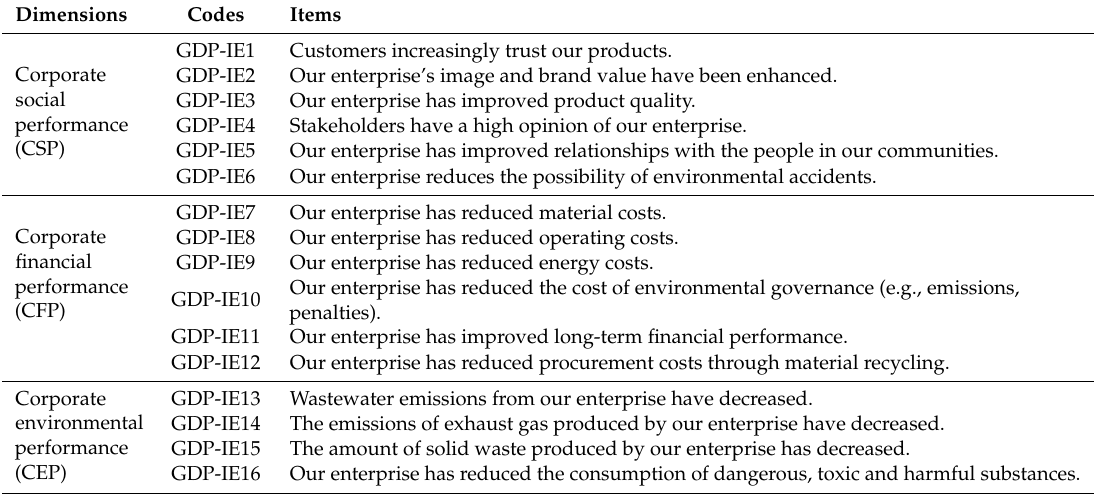
Table A4. Questionnaire items on the green development performance of industrial enterprises (GDB-IE)